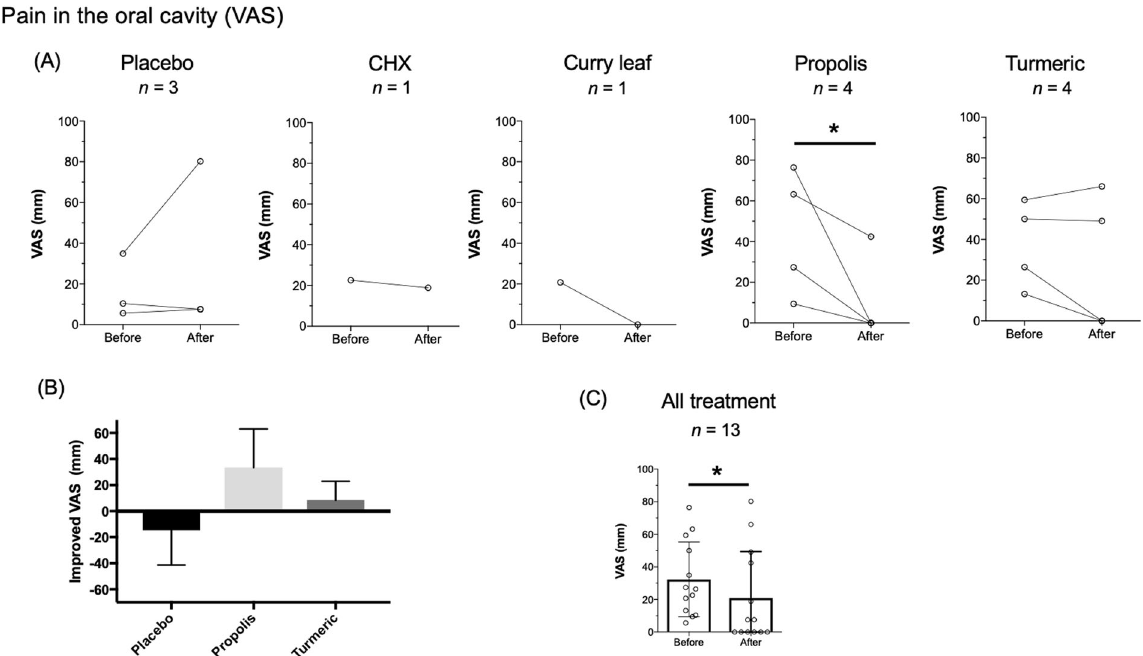
Fig. 4 Effect of intervention on oral mucosal pain. A Evaluation of mucosal pain in the oral cavity in each group. The transition of the VAS of oral mucosal pain (mm) in every patient before and after the intervention is denoted by circles and the connecting line. B Improved VAS of oral mucosal pain (mm) between every group. C Evaluation of oral mucosal pain in all treatment groups. The bar graph of VAS of oral mucosal pain (mm) with average ± SD is shown. VAS scores of individual subjects ( n = 13) are also plotted in the graph. * P ≤